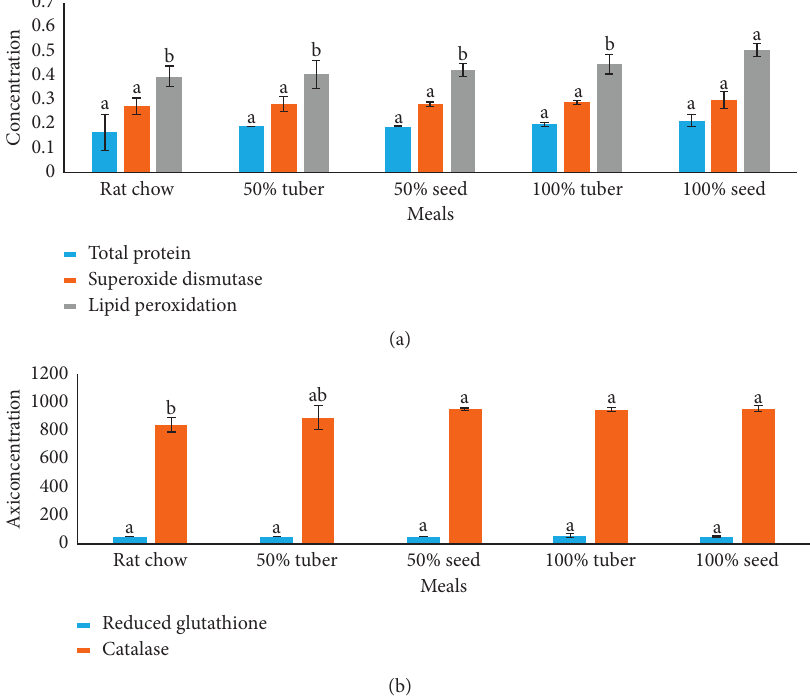
Figure 3: Effect of AYB seed and tuber meals on the levels of (a) lipid peroxidation (LPO), total protein, and superoxide dismutase; (b) reduced glutathione (GSH) and catalase in the liver of healthy Wistar rats 72h after administration. Means followed by the same letters are not significantly different ( p < 0 . 05). SOD (unit mg − 1 protein), GSH (mmoles min − 1 mg − 1 protein), LPO (unit mg − 1 protein), catalase (mmoles min − 1 mg − 1 protein), and total protein (mg − 1 protein).